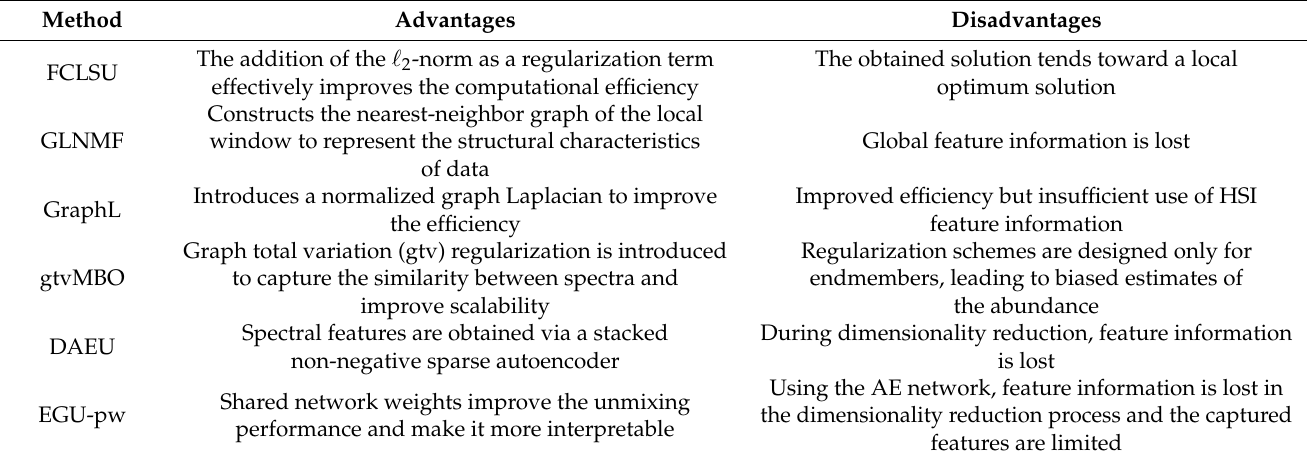
Table 1. Advantages and disadvantages of different unmixing